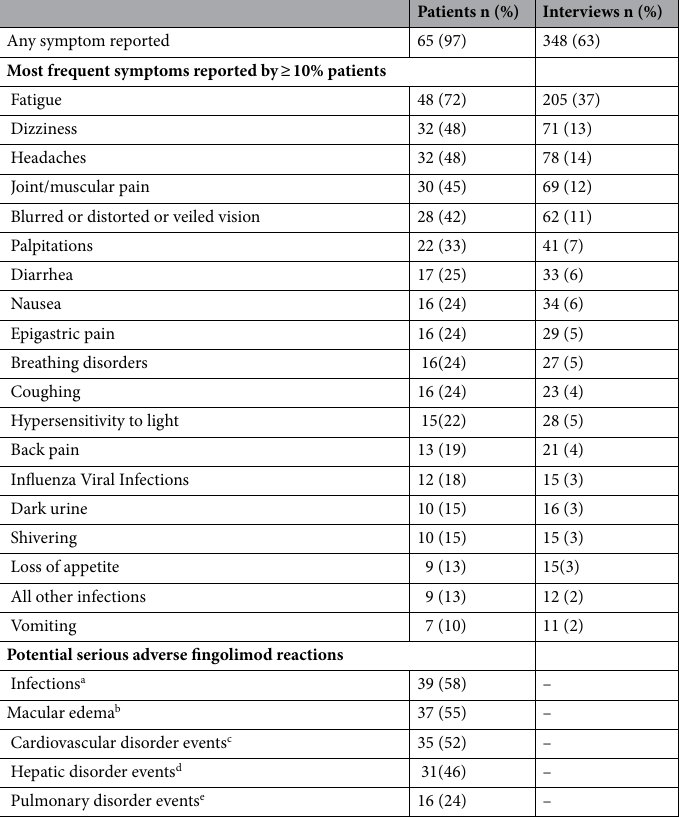
Table 2. Most frequent symptoms reported by ≥ 10% patients (n = 67) during the F-PSP interviews (n = 553) and number of patients who reported symptom(s) of a potential serious adverse fingolimod reaction from 2013 to 2016. n: number. a At least two cumulative symptoms: fatigue; nausea; vomiting; fever; joint/muscular pain; shivering; herpes; shingles; b At least one of the following symptoms: blurred, distorted, or veiled vision; shaded or black spot in the center of vision; hypersensitivity to light; change in color perception; c At least two cumulative symptoms: fatigue; dizziness; palpitations; d At least two cumulative symptoms: fatigue; nausea; vomiting; epigastric pain; loss of appetite; yellow skin or eyes; dark urine; e Breathing disorders.